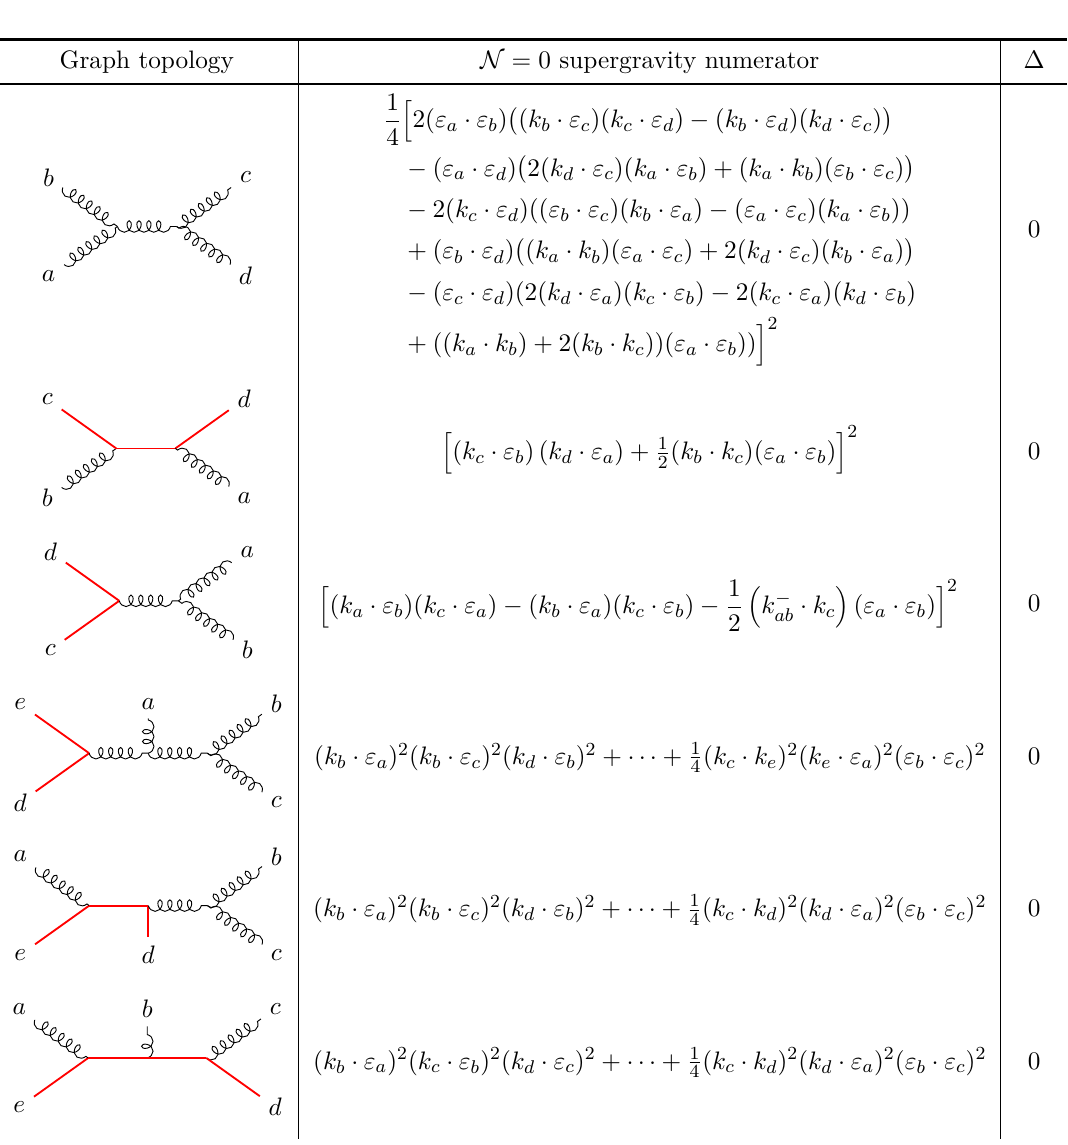
Table 1 . Tree amplitude graphs for one massive scalar at four and five-point, where k ij = k i + k j and k − = k i − k j . The correction ∆ should be subtracted from the N = 0 supergravity dressing to ij obtain the pure graviton